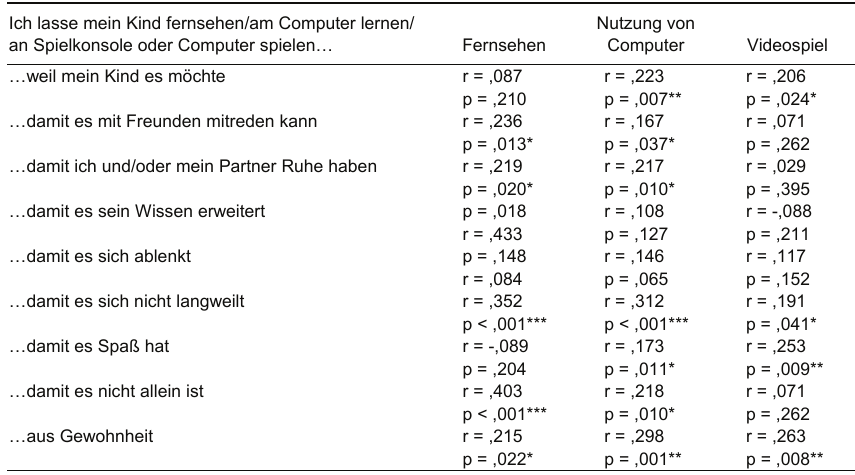
Tabelle 3: Korrelationen zwischen funktionaler Medienerziehung der Eltern und Medienkonsum ihrer Kinder für das Fernsehen (Studie 1) und Computer und Videokonsole (Studie